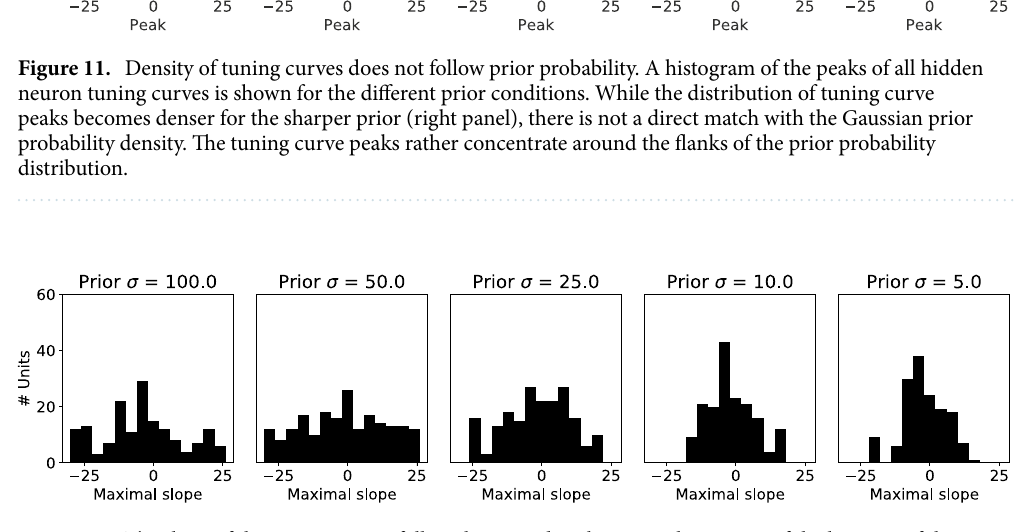
Figure 12. The slope of the tuning curves follow the prior distribution. A histogram of the location of the maximal slope (region most sensitive to stimulus changes) of every tuning curve is plotted for the different prior distributions. The density of maximal slopes concentrates more for the sharper prior probability distribution (right panel), forming a Gaussian bell